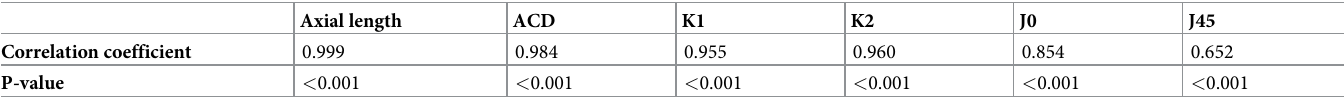
Table 3. Pearson correlation of ocular parameters reading between two